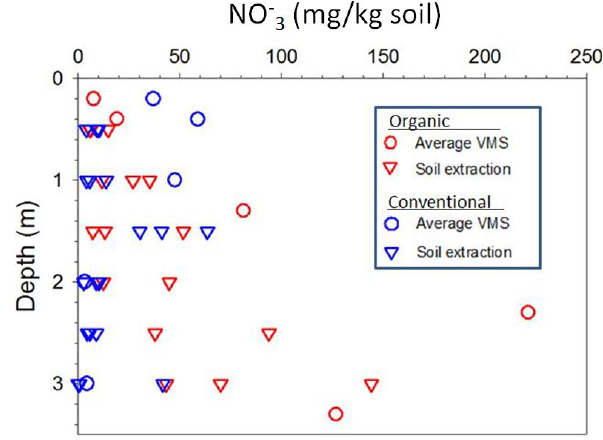
Fig. 5. Isotopic composition of δ 15 N vs. δ 18 O of nitrate in the water samples from the vadose zone underlying organic (Org) and conven- tional (Con) greenhouses with respect to typical values in common N sources (VSMOW refers to Vienna Standard Mean Ocean Water).